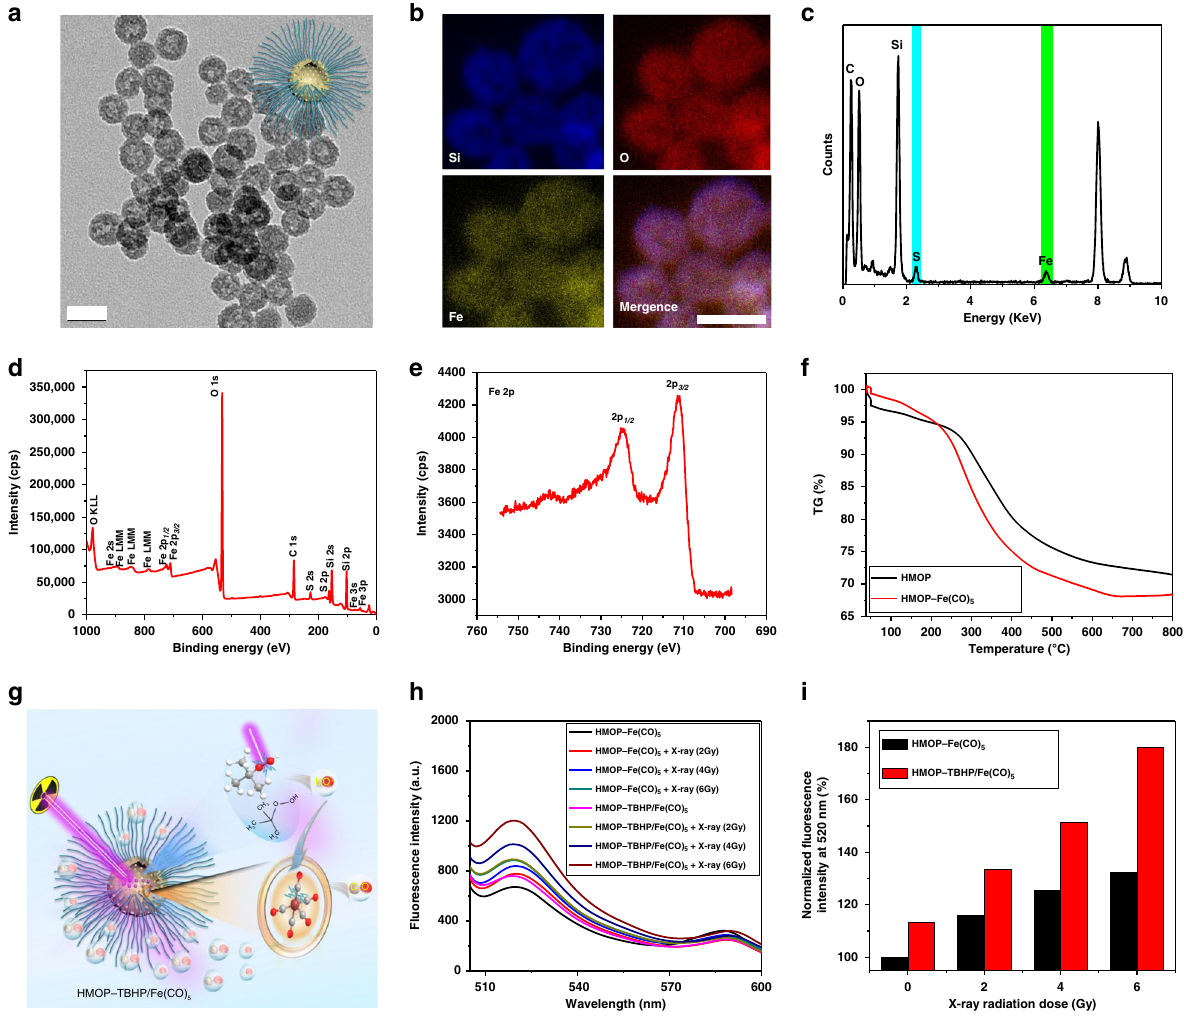
Fig. 6 Construction of HMOP-TBHP/Fe(CO) 5 and X-ray-activated CO release. a TEM image of HMOP-Fe(CO) 5 . Scale bar: 50 nm. b Elemental mapping (Si, O, Fe) of HMOP-Fe(CO) 5 . Scale bar: 50 nm. c EDS spectrum of HMOP-Fe(CO) 5 . d X-ray photoelectron spectroscopy (XPS) spectrum of HMOP-Fe (CO) 5 . e Binding energies of Fe( 2P 3/2 ) and Fe( 2P 1/2 ) correspond to 711 and 724 eV, respectively, indicating the attachment of Fe(CO) 5 to HMOP. f Thermo-gravimetric (TG) curves of HMOP and HMOP-Fe(CO) 5 . g Schematic of X-ray-triggered CO release from HMOP-TBHP/Fe(CO) 5 . h Fluorescence spectra of COP-1 probe subjected to varied doses (0, 2, 4, and 6 Gy) of X-ray irradiation in the presence of HMON-Fe(CO) 5 or HMOP-TBHP/Fe(CO) 5 . i Evaluation of CO generation based on the normalized fl uorescence intensity of COP-1 probe at 520